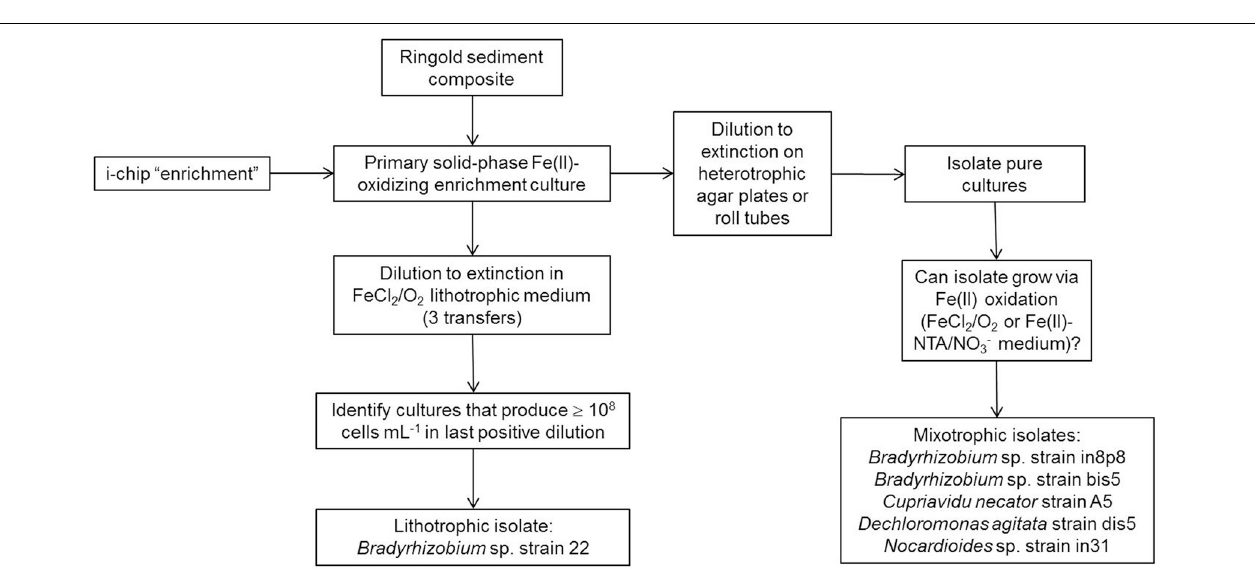
FIGURE A2 | Strategy for enrichment and isolation of Fe(II)-oxidizing